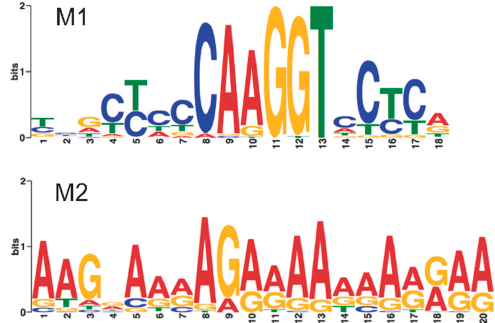
Figure 3. Overrepresented motifs in the promoter regions of the most DZR genes. These motifs were found using the MEME algorithm after analyzing DNA sequences expanding from − 20 to − 1000 bp from the predicted translation start codons of the ORFs of 67 DZR genes (for numbering purposes, we assigned position − 1 to the nucleotide preceding the A of the ATG start codon).